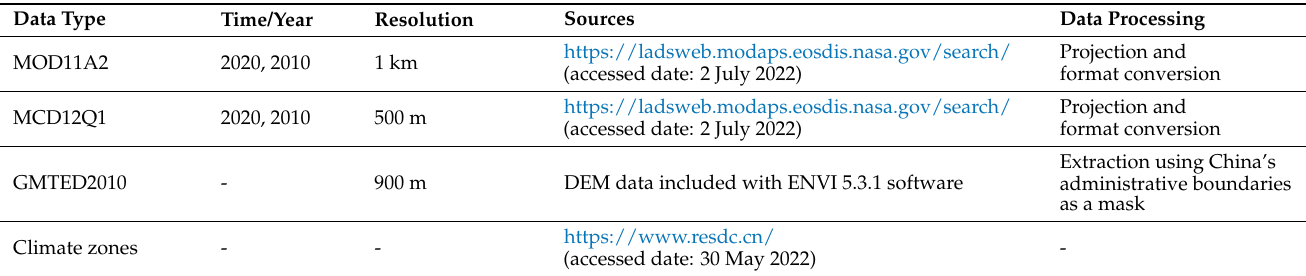
Table 1. Data sources and description.